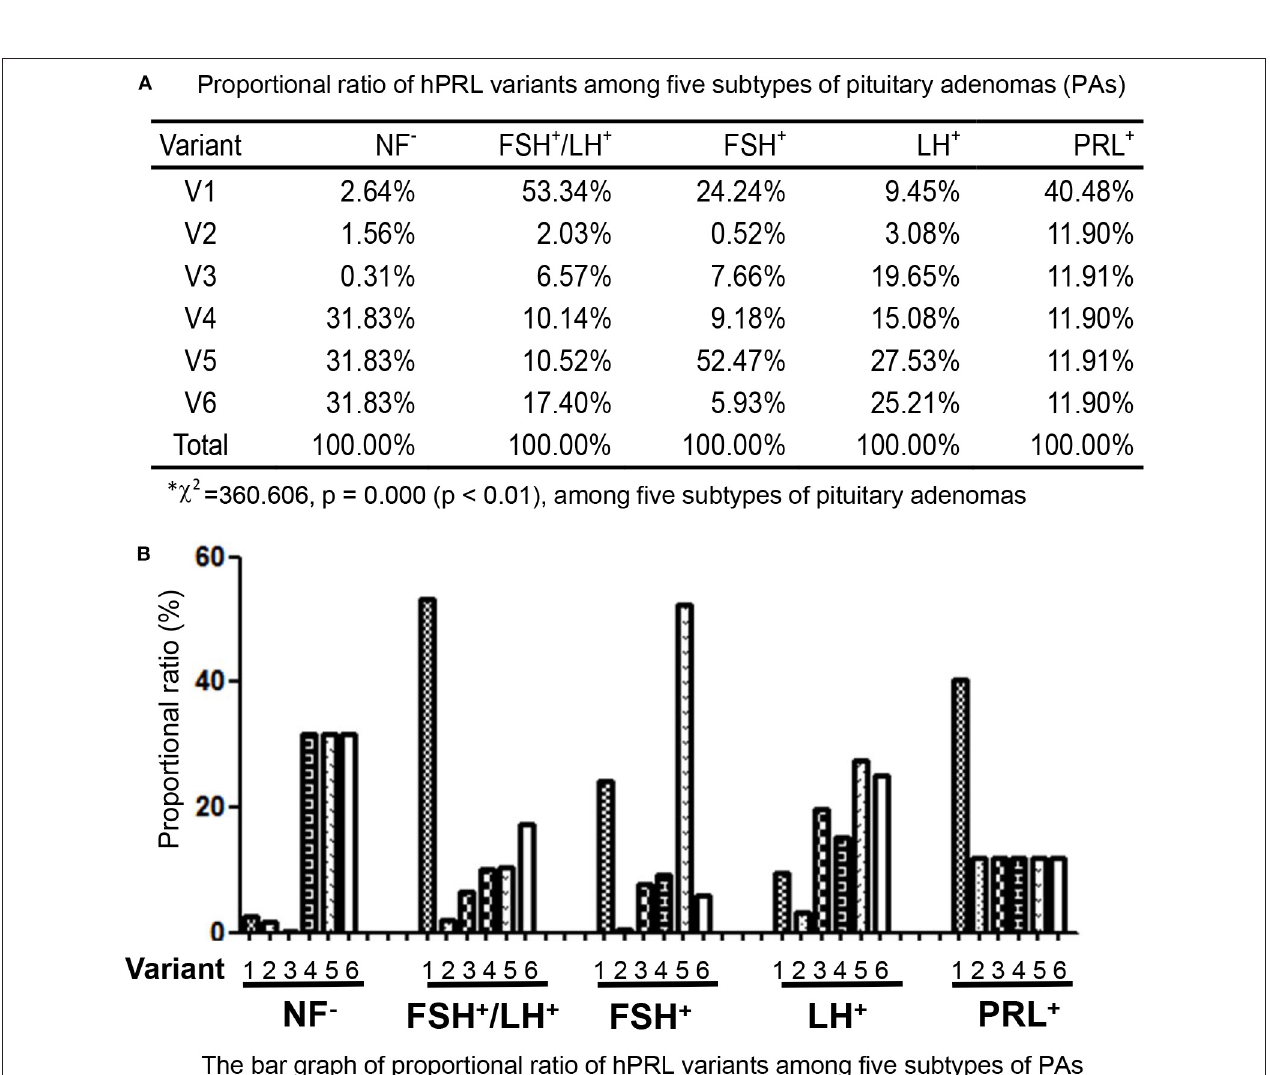
FIGURE 4 | Comparison of the proportional ratio of PRL variants among different subtypes of pituitary adenomas.